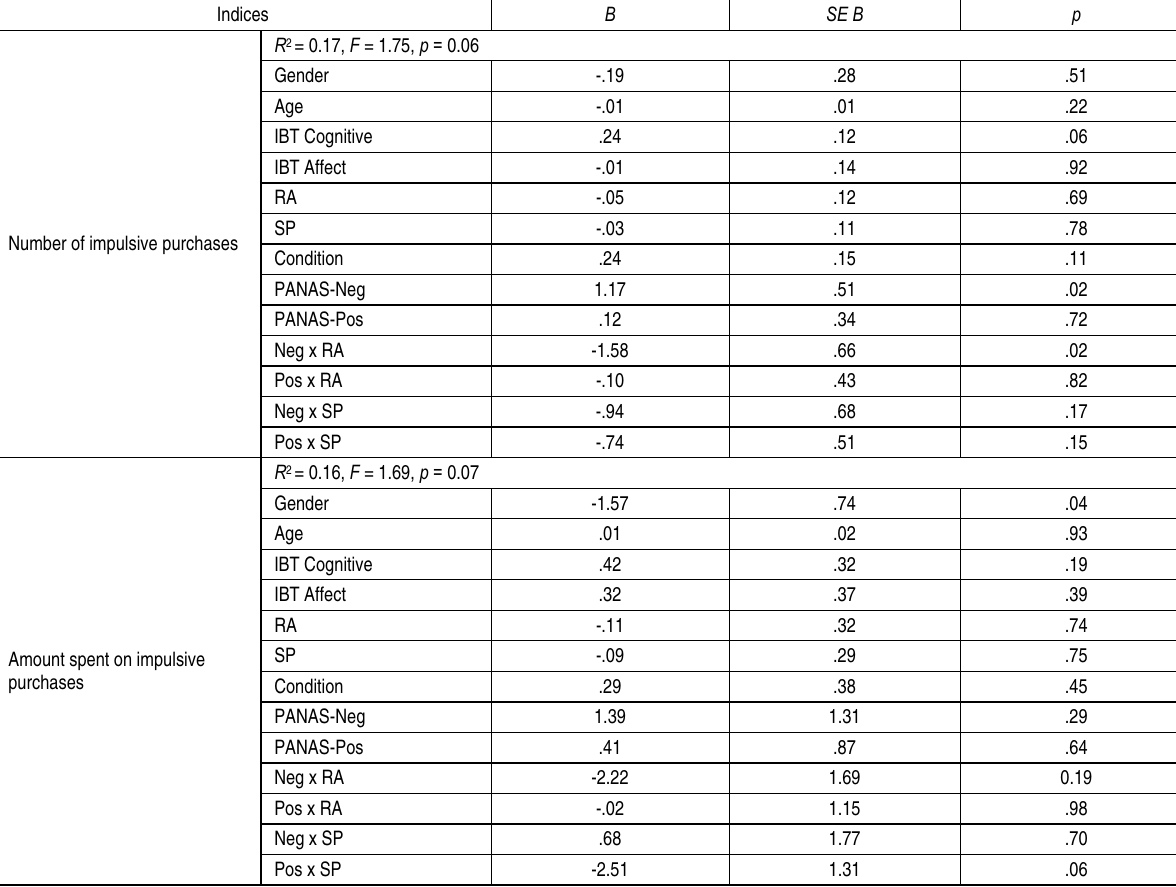
Table 2. Regression analyses to examine the interaction between emotion and emotion regulation strategies